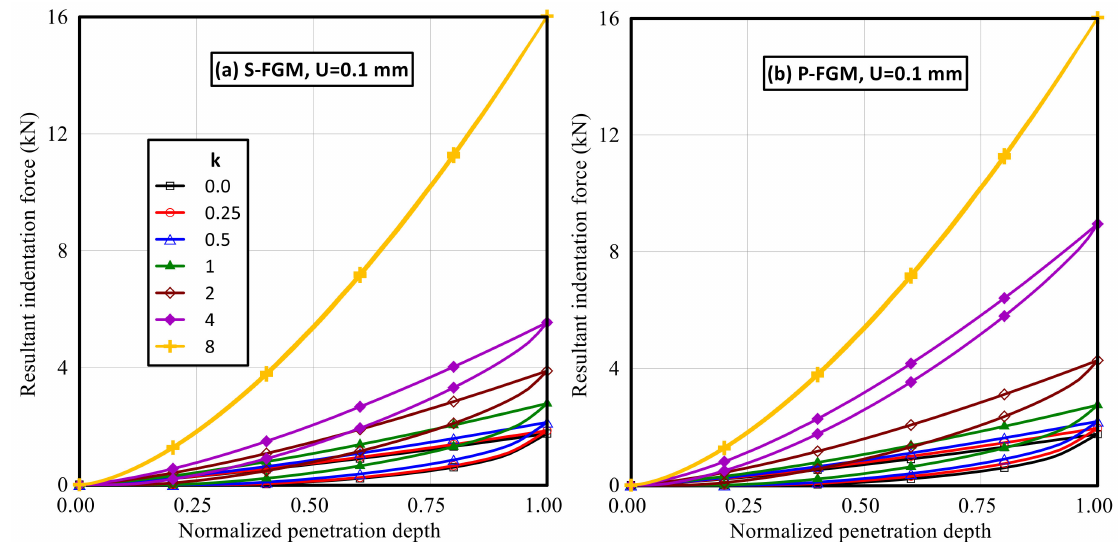
Figure 7. Indentation force–penetration depth curves for the elastoplastic Ti/TiB specimen at different gradient indices; ( a ) S-FGM, and ( b ) P-FGM.